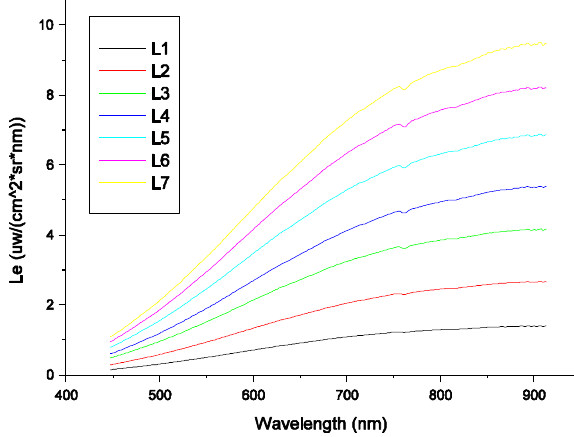
Figure 13. Spectral radiance curves of the FISS interpolated by a multilinear method. The level number denotes the number of bulbs in the integrating sphere that were switched on.